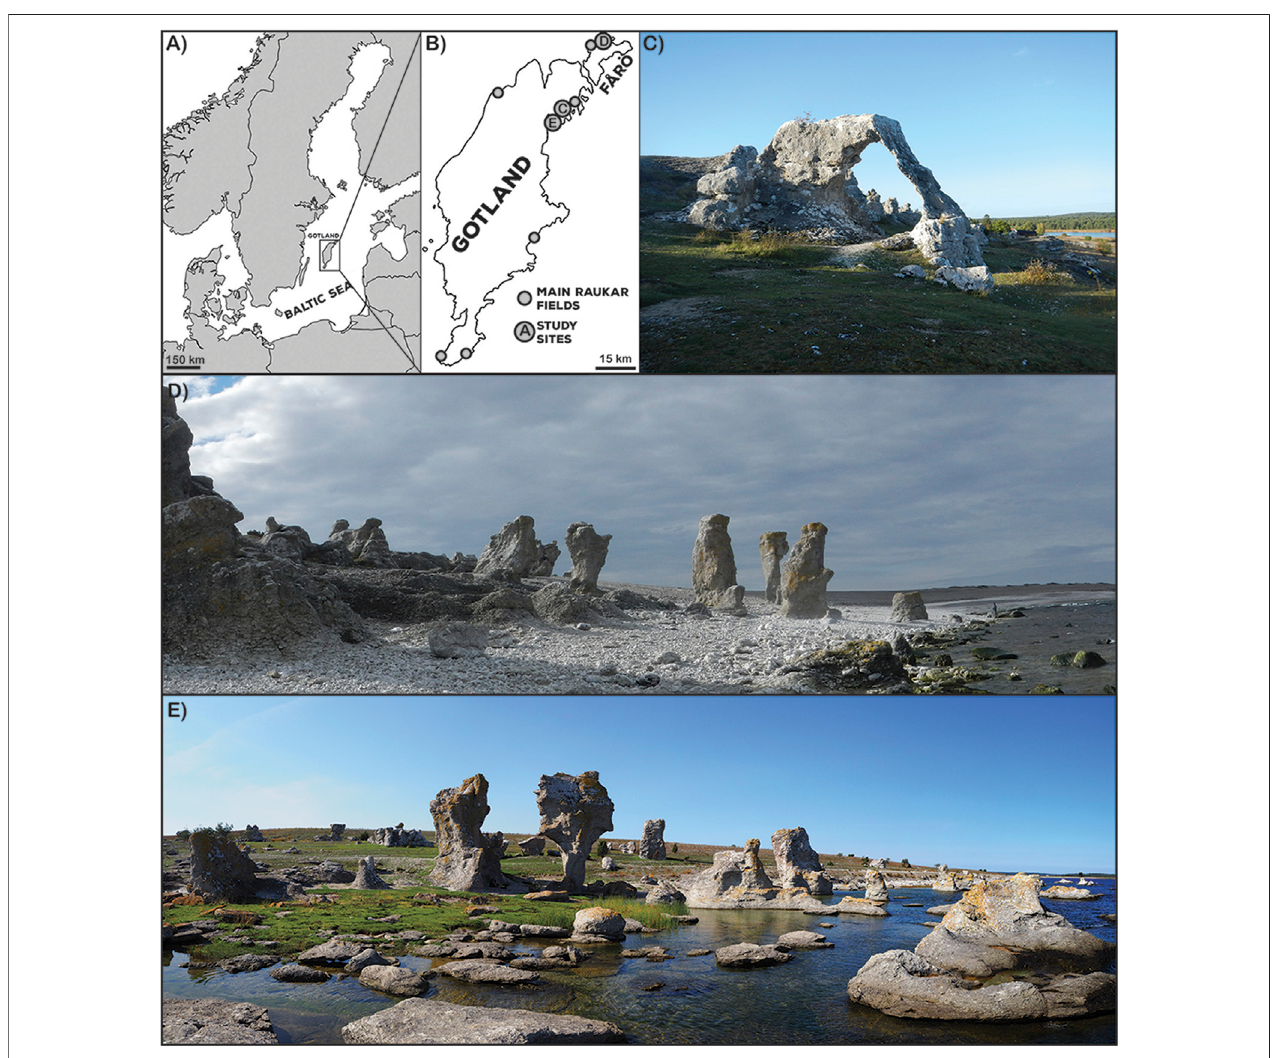
FIGURE1| Studyarea. (A) LocationofGotlandandsisterislandFäroincentralBalticSea. (B) MapofGotlandandFäroislandswiththelocationofmajorrauk fi elds and study areas; (C) rauk fi eld in Lergrav; (D) rauks in Langhammars; and (E) Asundens rauks.